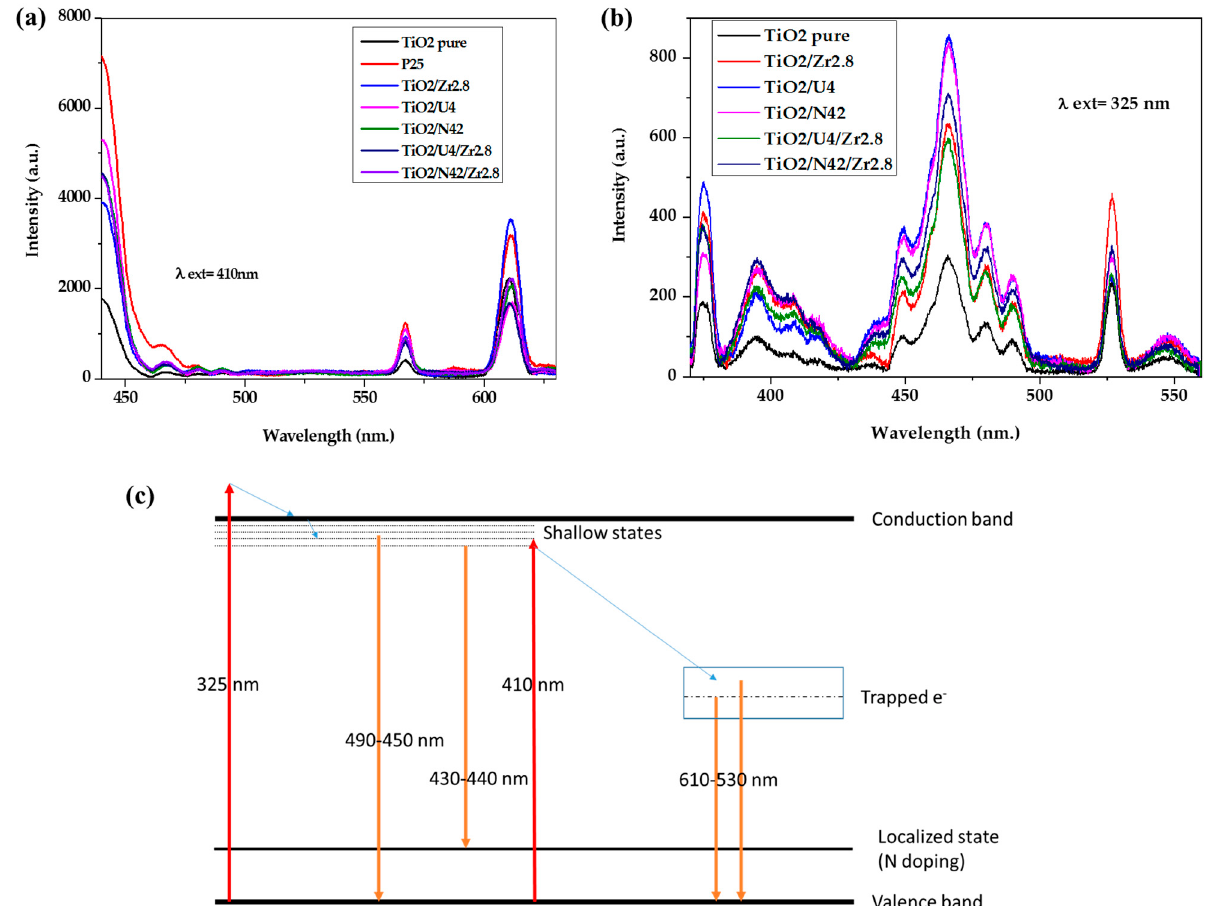
Figure 11. ( a ) Photoluminescence spectra (excitation source: 410 nm) of Evonik P25, pure TiO 2 , TiO 2 /Zr2.8, TiO 2 /U4, TiO 2 /U4/Zr2.8, TiO 2 /N42, and TiO 2 /N42/Zr2.8 samples (caption in the figure). ( b ) Photoluminescence spectra (excitation source: 325 nm) of pure TiO 2 , TiO 2 /Zr2.8, TiO 2 /U4, TiO 2 /U4/Zr2.8, TiO 2 /N42, and TiO 2 /N42/Zr2.8 samples (caption in the figure). ( c ) Proposed energy states for N-(co-)doped TiO 2 , inspired from the work in [63].